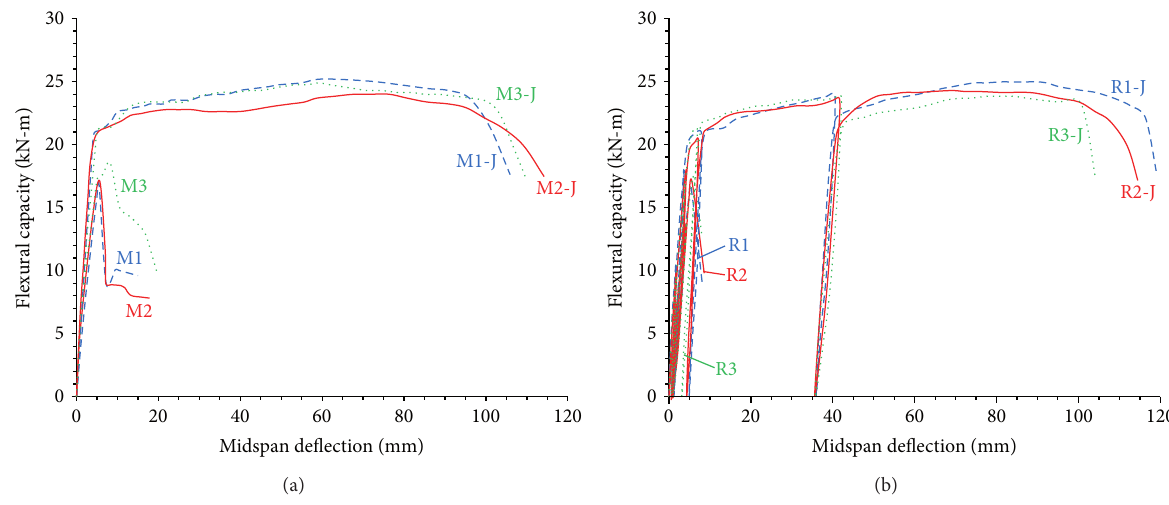
F 7: Comparisons of the �exural capacity versus midspan de�ections curves of the tested